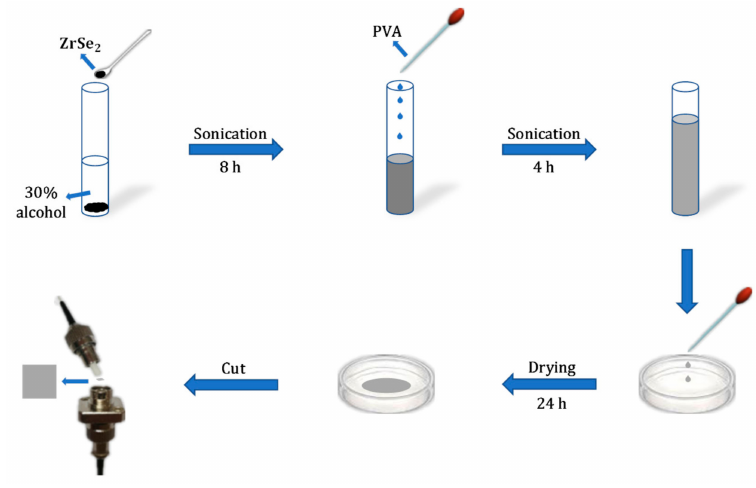
Figure 1. The preparation process of the ZrSe 2 -PVA film-type